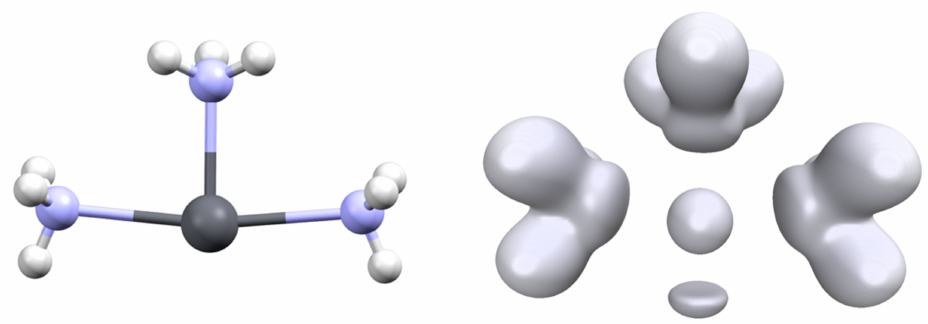
Figure 7. Structure (T shape) of the transition state for the interconversion of the [Pb(NH 3 ) 3 ] 2+ complex ( left ) and associated ELF analysis (( right ), isovalue η =